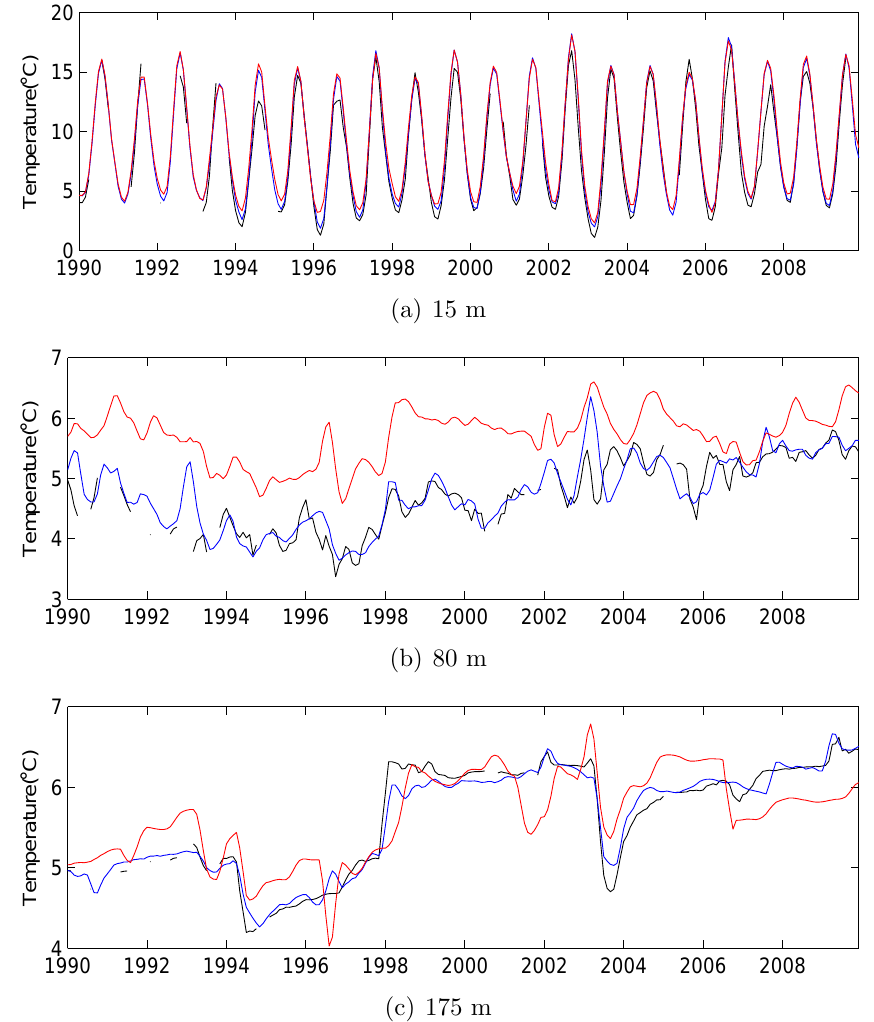
Fig. 5. The time series of temperature at 57.15 ◦ N, 19.92 ◦ E for the depth of (a) 15m, (b) 80m, and (c) 175m. The red is the free run, the Figure 5: The time series of temperature at (57.15 ◦ N, 19.92 ◦ E) for the depth blue is the reanalysis and the black is for of (a) 15 m, (b) 80 m and (c) 175 m. The red is the free run, the blue is the reanalysis and the black is for observations.